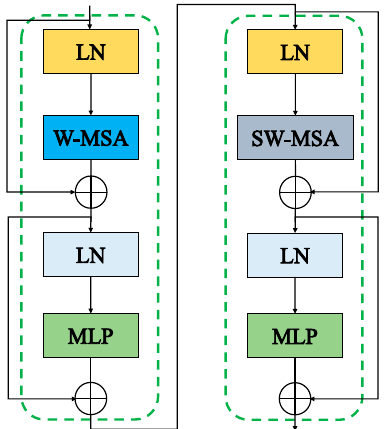
Figure 5. Working principle of W-MSA and SW-MSA.